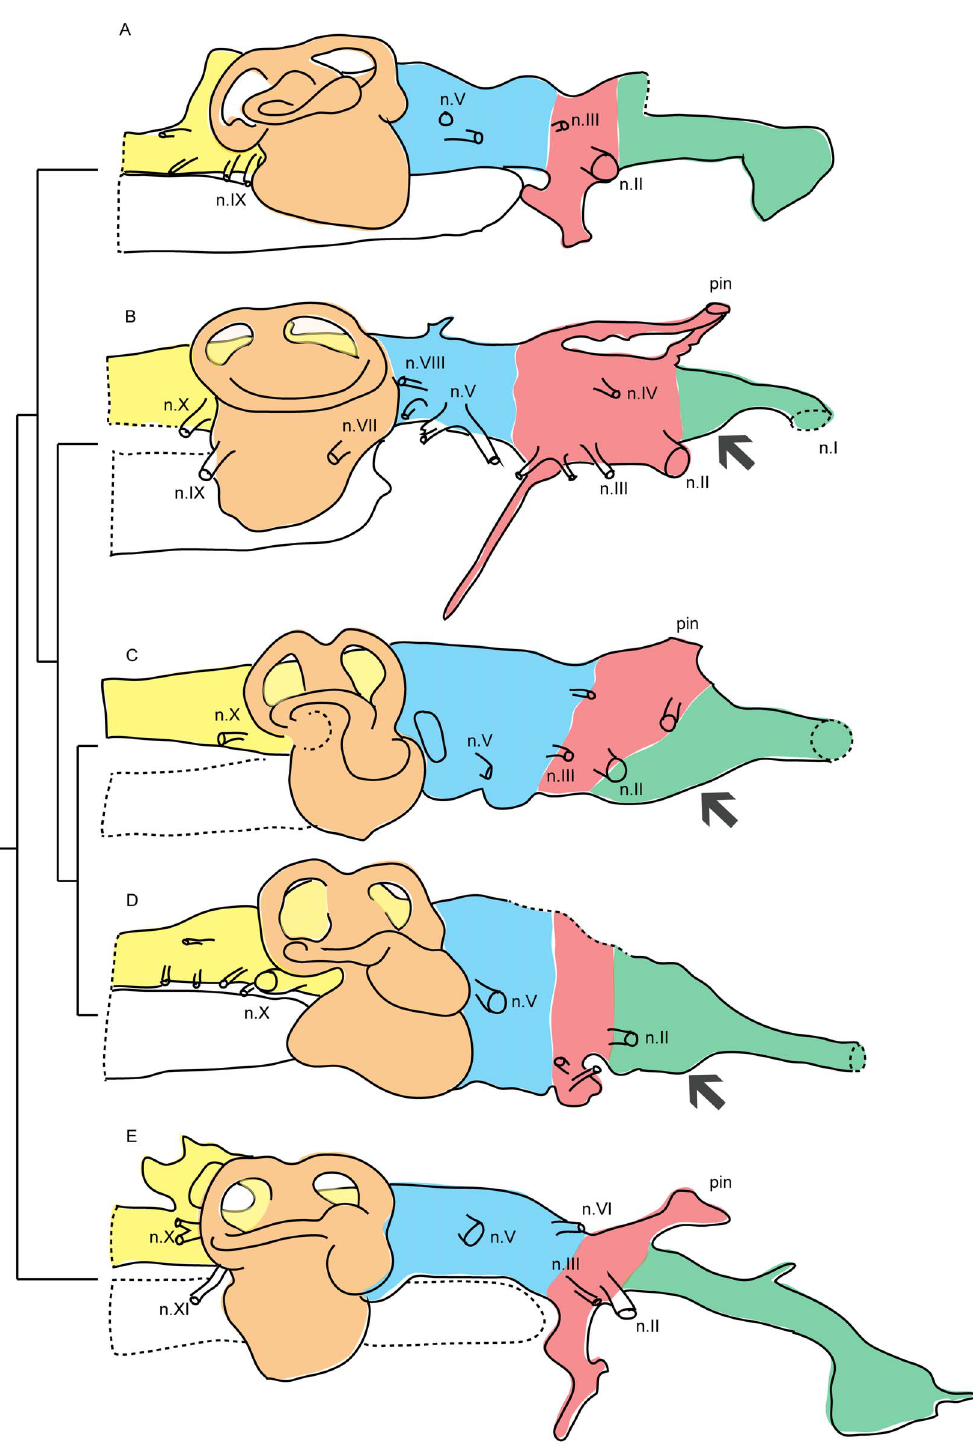
Figure 5. A, Youngolepis praecursor (from Chang [25], fig. 19); B, Dipnorhynchus sussmilchi (from Campbell and Barwick [22], fig. 25); C, Chirodipterus wildungensis (from Sa¨ve-So¨derbergh [21], fig. 9); D, Rhinodipterus kimberleyensis (WAM 09.6.149); and E, Eusthenopteron foordi (from Jarvik [69], figs. 57, 59). Not to scale, anterior is to the right, grey arrows indicate telencephalic ventral expansion. Abbreviations: